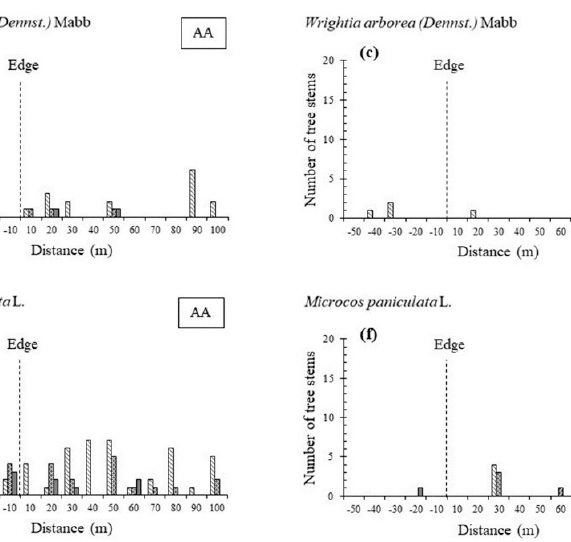
Figure 4. Diameter class distribution in nine stands of three exotic plantations. (a) Eucalyptus camal ‐ dulensis (EC), ( b ) Acacia auriculiformis (AA), and ( c ) A. mangium (AM) stands.